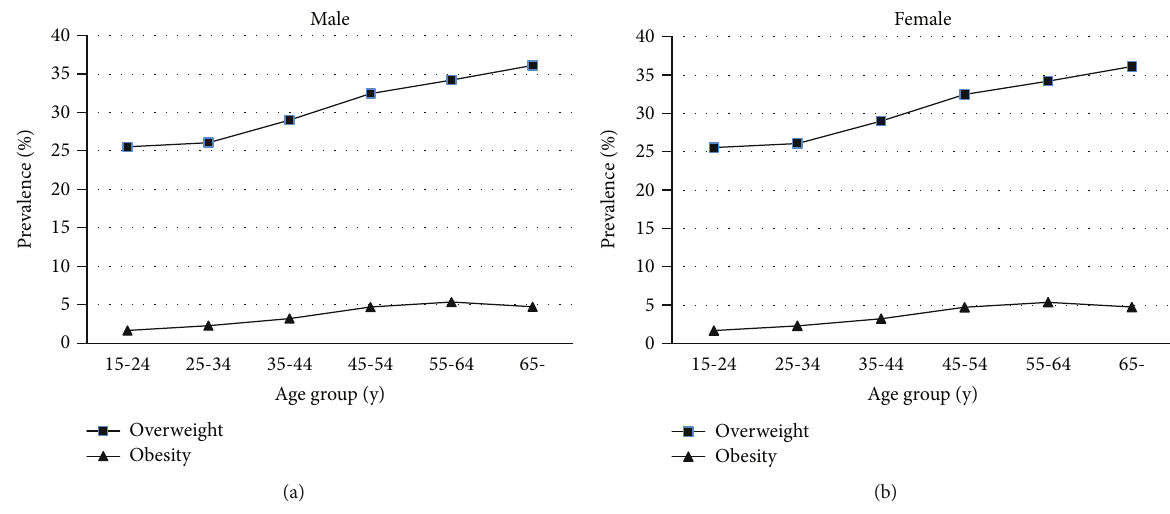
Figure 1: Prevalence of overweight and obesity by di ff erent age groups in (a) males and (b)